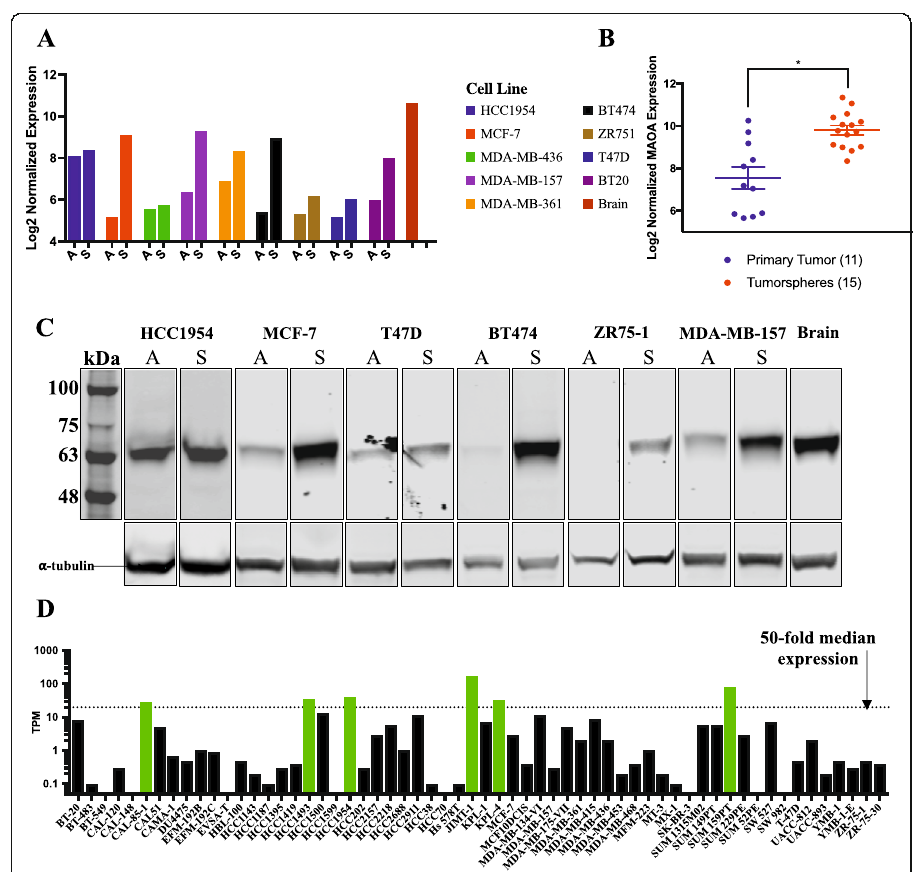
Fig. 1 Monoamine oxidase-A expression increases at the transcript and protein level in human breast tumor cells propagated as tumorspheres. a Log2 normalized MAO-A transcript counts from Nanostring nCounter analysis of total RNA isolated from human breast tumor cell lines grown adherently (A) or as tumorspheres (S). Human brain RNA was included as a positive control. b Log2 normalized MAO-A expression from microarray analysis of primary patient tumor cells propagated as tumorspheres [FC = 4.80; p = 5.30E-05]. c Western blot analysis of 6 human breast tumor cell lines grown adherently (A) or as tumorspheres (S) with a primary antibody that binds to MAO-A at its approximated molecular weight of 61 kDa. An α -tubulin loading control was included. Lanes were cropped from 3 separate blots as described in Additional file 5. d RNA sequencing data from 60 breast tumor cell lines was downloaded from Array Express [E-MTAB-2706]. Transcript abundance (transcripts per million; TPM) was plotted for each cell line. The green bars indicate cell lines that expressed MAO-A at a 50-fold higher level than the median TPM of all samples (black dotted